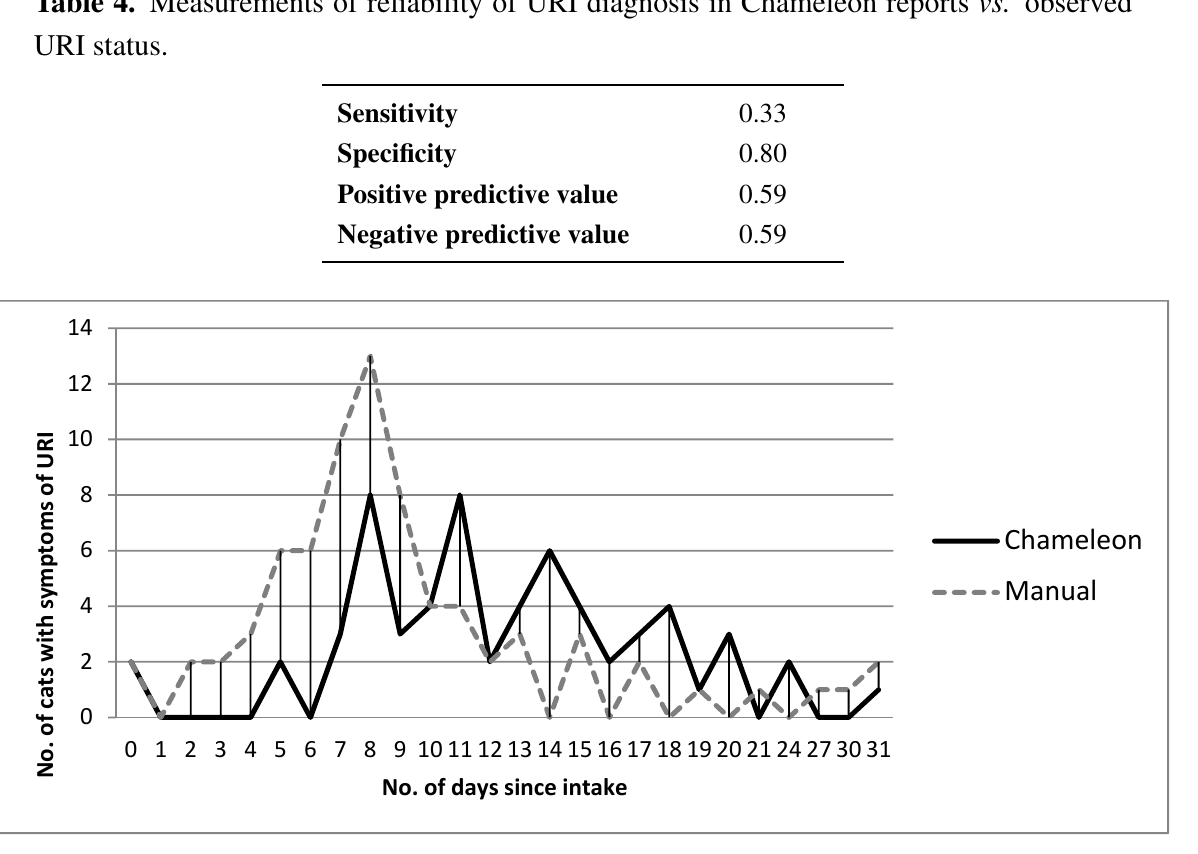
Figure 1. Comparing the number of days from a cat’s intake date until the onset of URI according to Chameleon and observer reports.